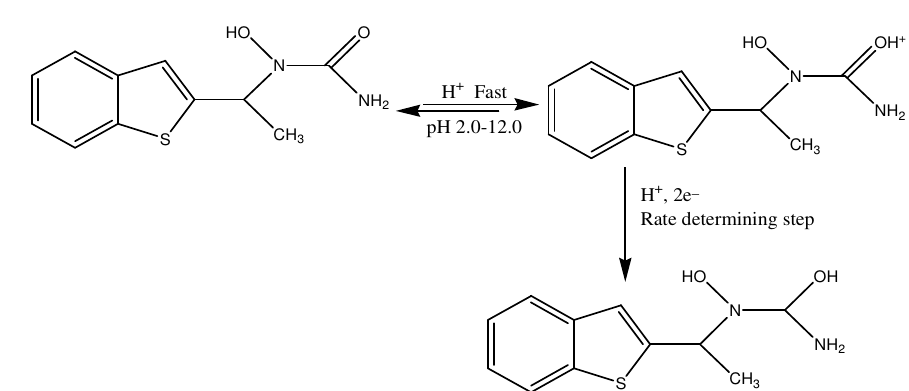
Scheme 1 . Electrochemical reduction of